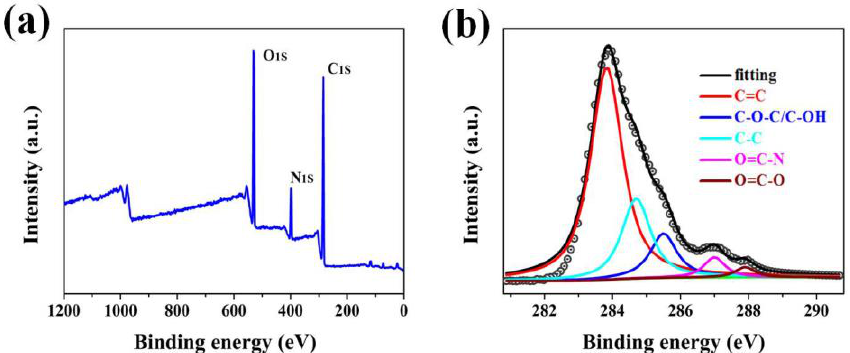
Figure 3. X-Ray spectroscopy (XPS) survey spectra of ( a ) GPLP; and ( b ) C1s XPS spectrum of